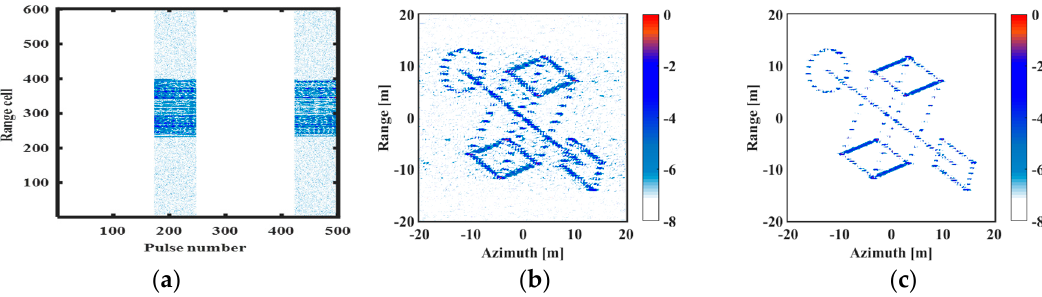
Figure 9. Range profiles and imaging results with GMS of 150 pulses: ( a ) Range profiles; ( b ) Imaging result of algorithm in [23]; ( c ) Imaging result of the proposed algorithm.